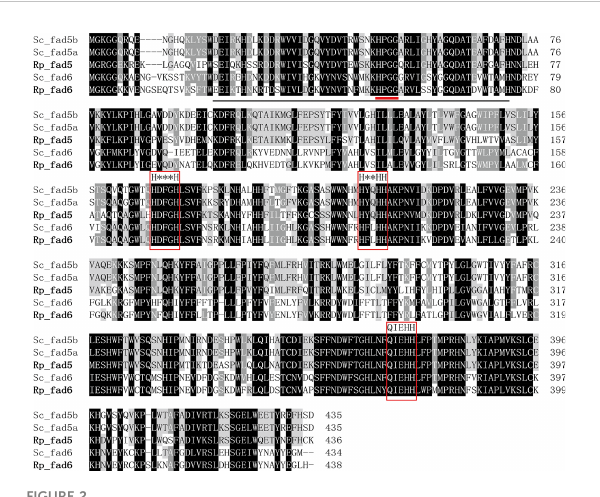
FIGURE 2 Alignment of the deduced amino acid (aa) sequences of Rp_fad5 and Rp_fad6 with D 5 Fads (Sc_fad5a, AWC67984.1 and Sc_fad5b, AWC67985.1) and D 6 Fad (Sc_fad6, AWC67986.1) from S.